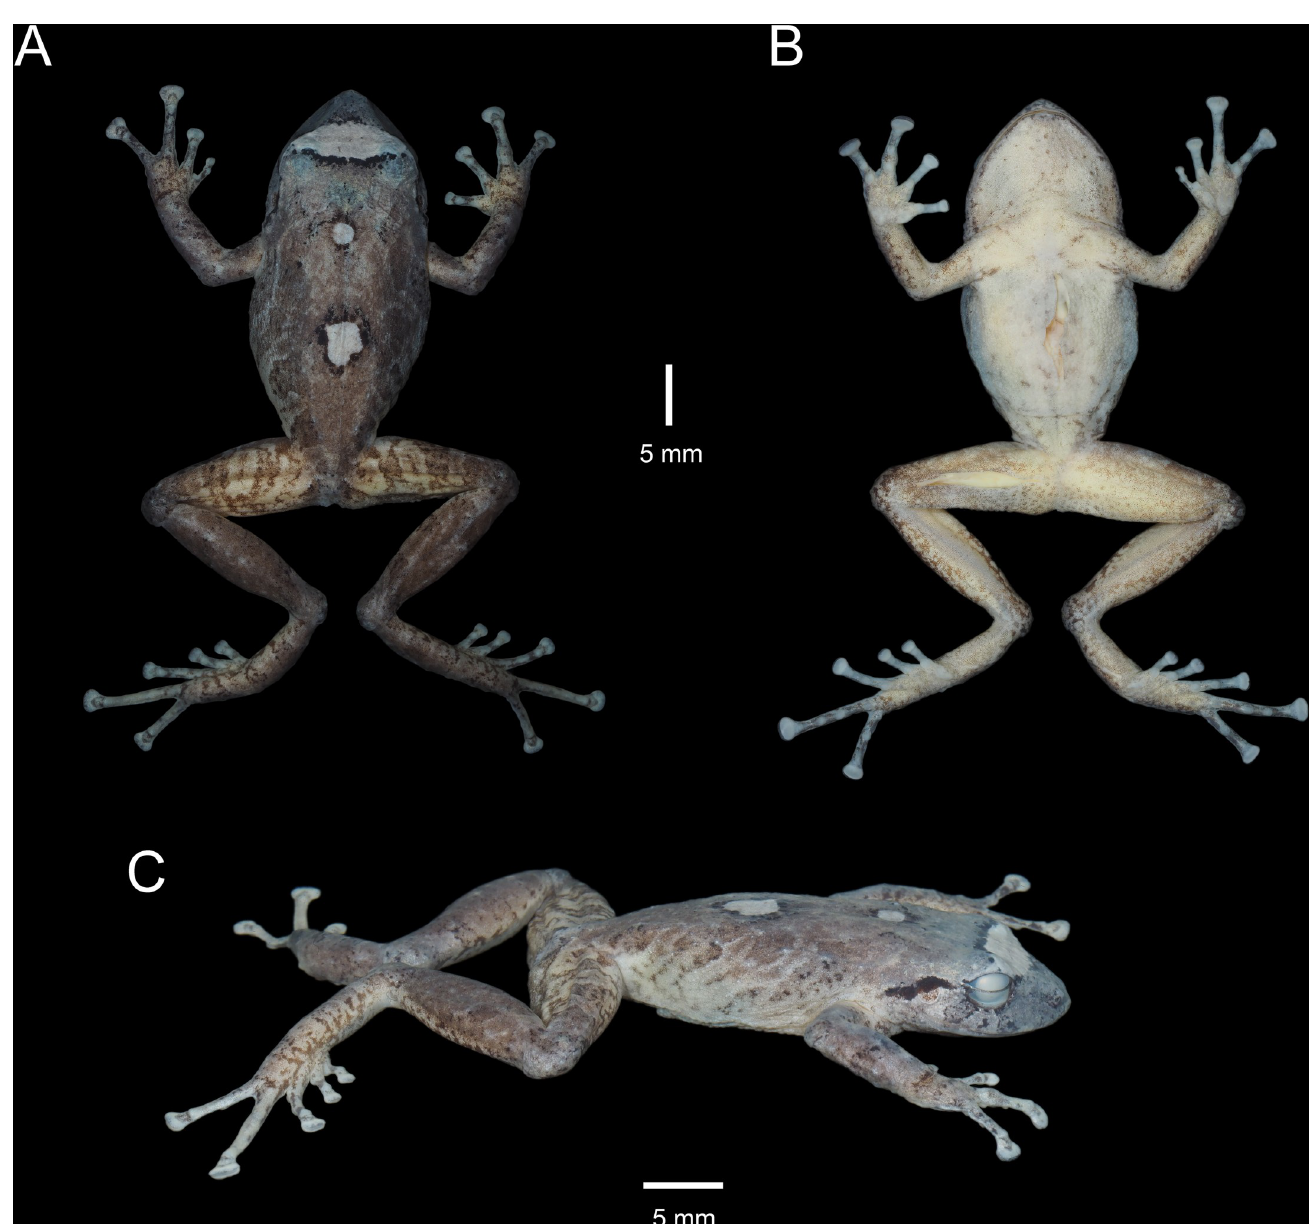
Fig 3. Holotype of Pristimantis lojanus sp. nov. (MUTPL 178, adult female) in preservative. A. Dorsal view; B. Ventral view; C. Lateral view.